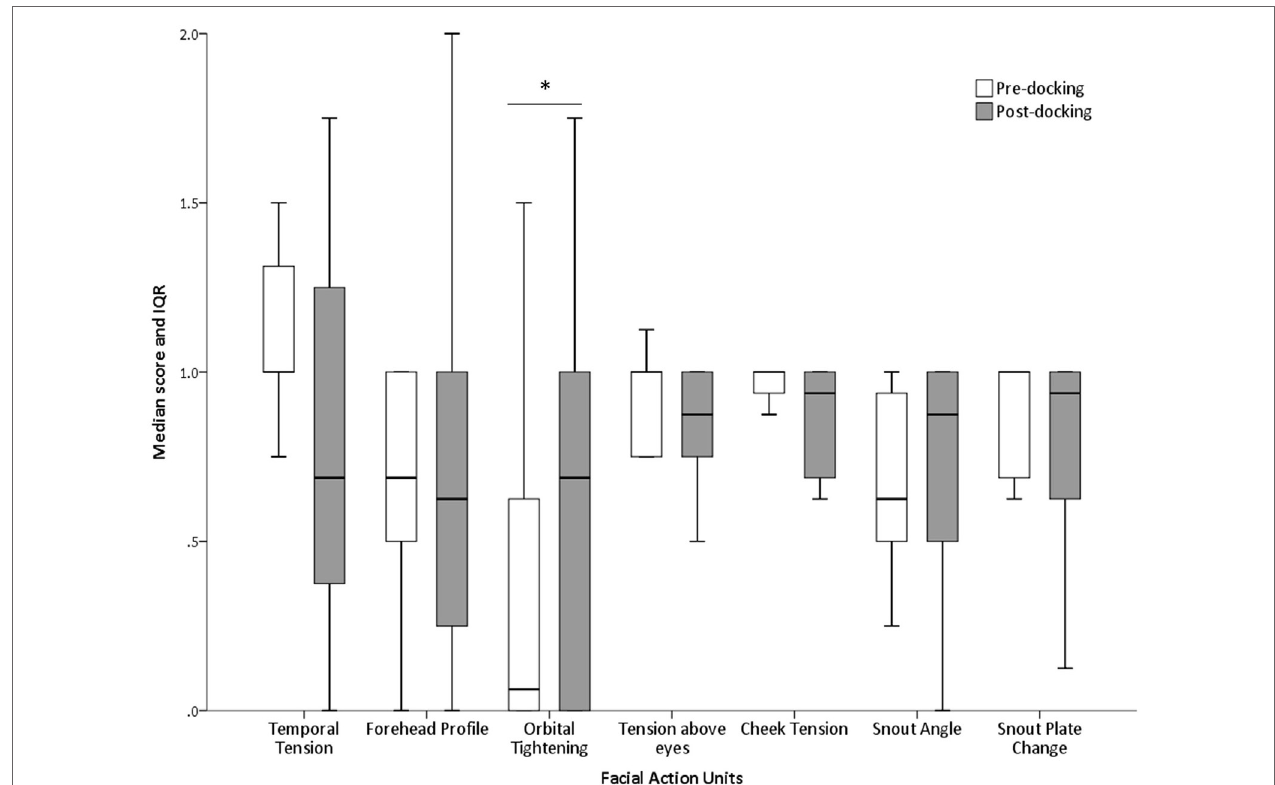
FigUre 4 | changes in FaU scores following tail docking . Median ( + IQR) of all scores assigned to each FAU pre and post-procedure. The asterisk denotes significant difference ( P <